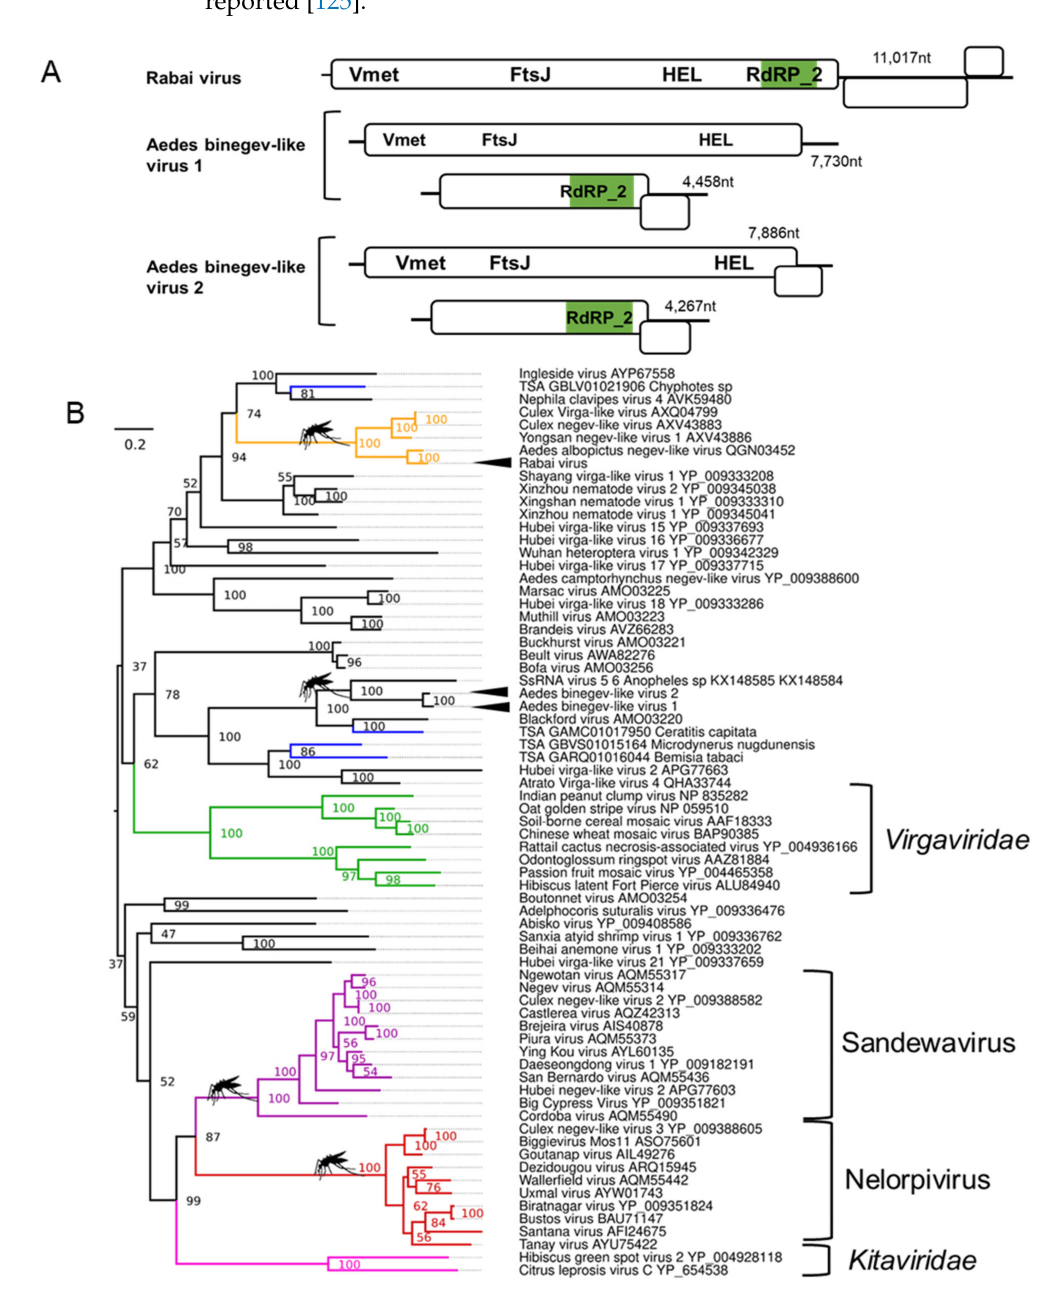
Figure 4. Novel positive-sense RNA viruses of Ae. albopictus and Ae. aegypti. ( A ) Genome organisation of Aedes negeviruses and bi-negeviruses. Vmet, Viral methyltransferase; FtsJ, Ftsj-like methyltransferase; HEL, helicase, and ( B ) phylogenetic placement of novel negeviruses based on concatenated MET, HEL, and RdRp_2 domains. Clades are coloured, indicating the mosquito nelorpivirus (red) and sandewavirus (purple) negevirus clades, as well as the Virgaviridae (green) and Kitaviridae (pink) groupings, a divergent mosquito negevirus clade is indicated in orange. Branch length indicates the number of amino acid substitutions per site. Consensus maximum-likelihood trees are produced using IQTree as per Figure